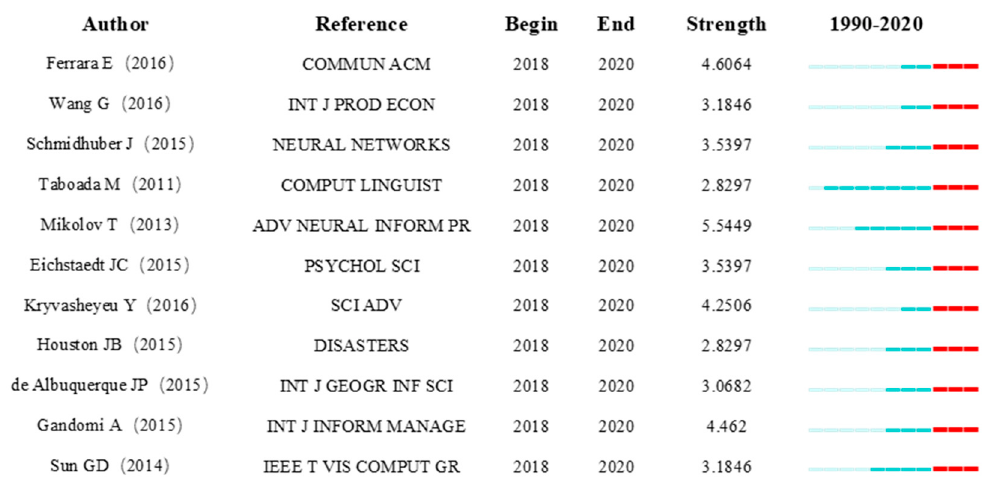
Figure 9. Co-citation articles burst in SMBD.